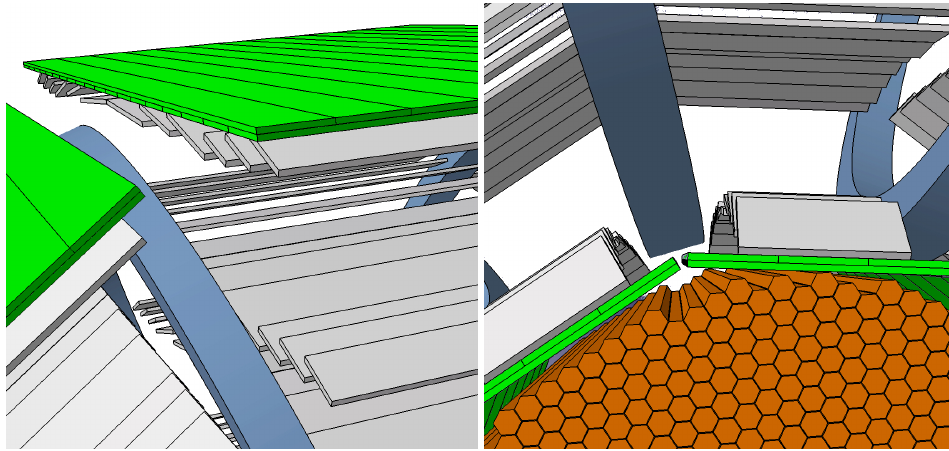
Figure 15. Details of the baseline layout proposed for the ToF outer ( left ) and inner ( right ) rings. The ToF plastic scintillating counters are shown in green, together with the magnet coils (blue), the silicon tracker sensors (gray), and the calorimeter crystals